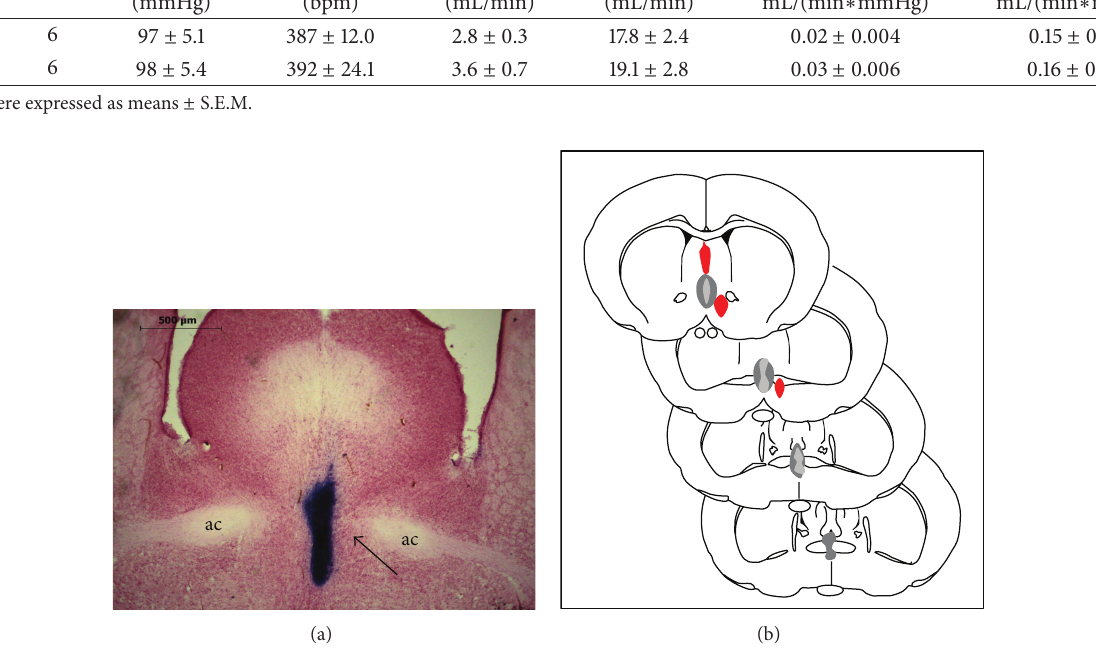
Figure 1: Typical injection site in the median preoptic nucleus (MnPO). (a) Photomicrograph of a coronal section of the forebrain of a representative site following a nanoinjection labeled with 4% Evans blue dye (arrow). (b) Four sequential coronal drawings showing the maximum (dark area) and minimum (gray area) extent of dye diffusion into the MnPO. Red spots indicated the extent of dye diffusion outside of the